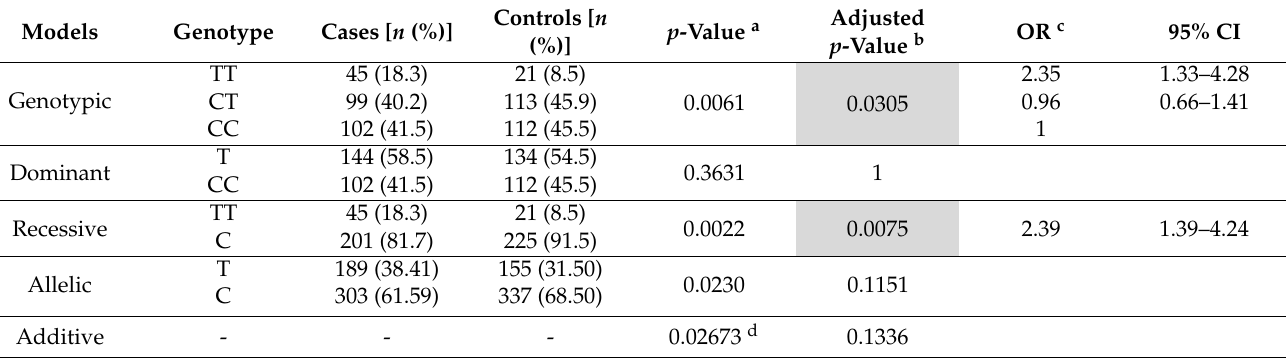
Table 2. Influence of VDR FokI (rs2228570) gene polymorphism on risk of cardiovascular disease.